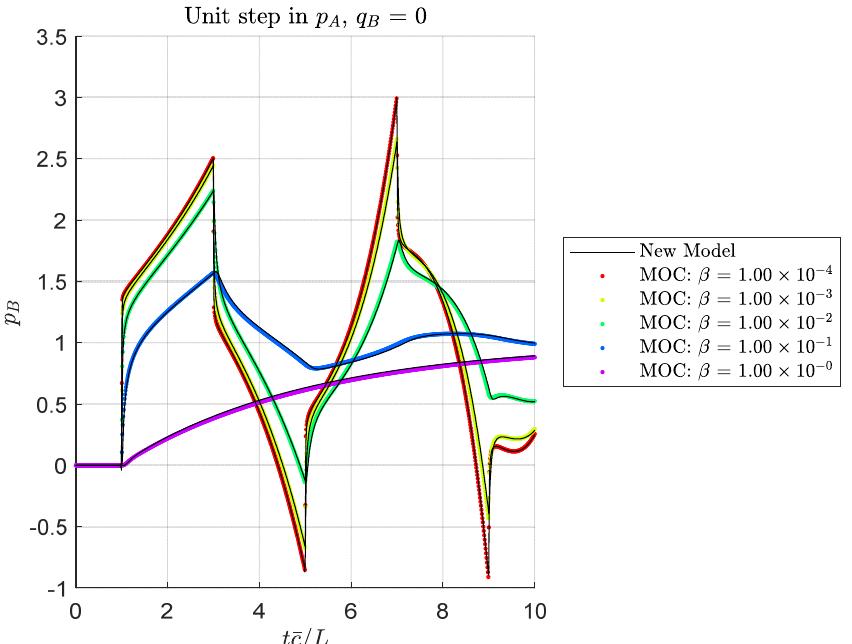
Figure 7. Outlet pressure response to a unit step in inlet pressure for a closed exit, showing the effect of dissipation number (for c B = 0.5 ).